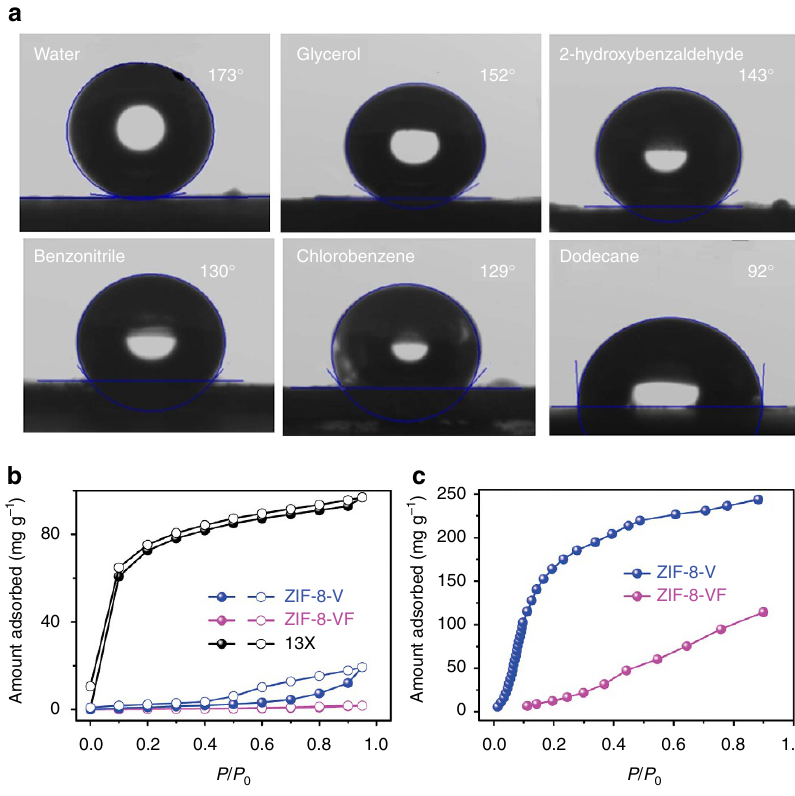
Figure 4 | Wettability tests and vapour sorption performance. ( a ) Contact angles of various liquid on the pressed pellet made using ZIF-8-VF sample, ( b ) water adsorption (solid symbols) and desorption (open symbols) isotherms collected at 298K and ( c ) toluene adsorption isotherms collected at